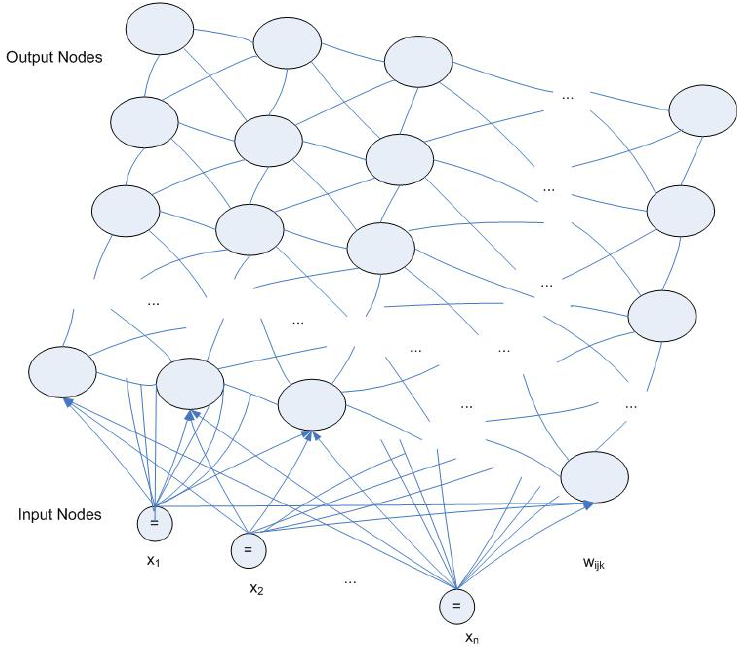
Figure 4. Kohonen SOM network with two-dimensional array of output nodes used to form feature